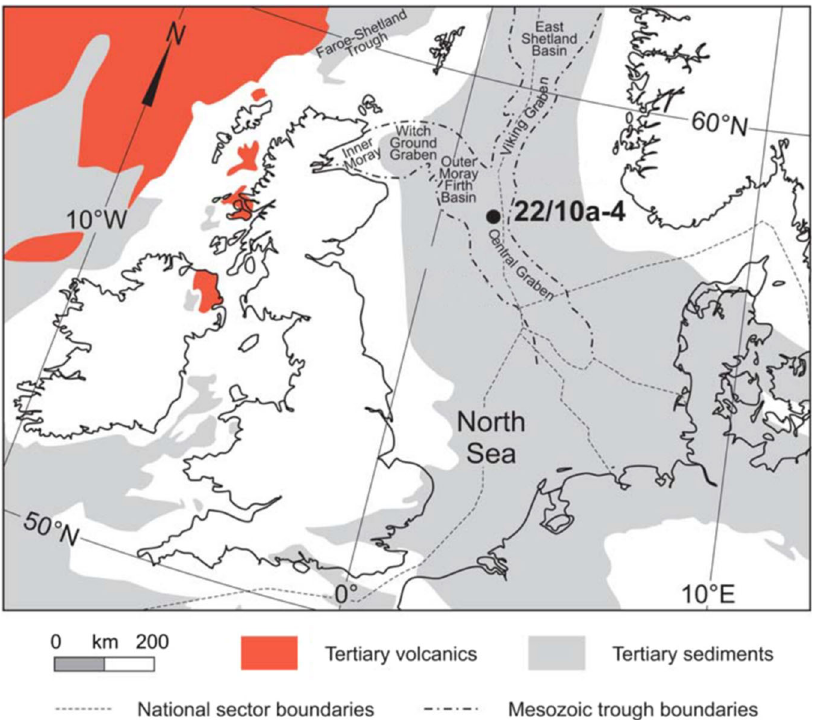
Fig. 1 | Map of the North Sea Basin, showing the location of well 22/10a-4 and the surrounding geologic features and Paleogene deposits. Figure 1 is reproduced from ref 33. © The Mineralogical Society of Great Britain and Ireland 2016, published by Cambridge University Press, reproduced with